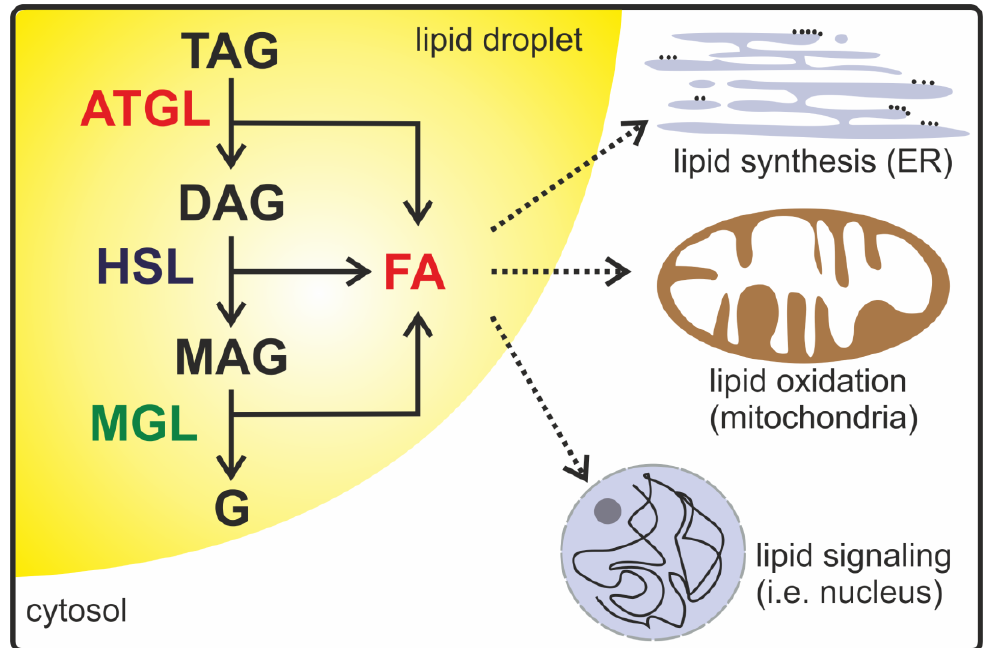
Figure 1. A schematic description of intracellular lipolysis. In the lipolytic active state, adipose triglyceride lipase (ATGL), hormone-sensitive lipase (HSL), and monoacylglycerol (MAG) lipase (MGL) are localized on the surface of lipid droplets in the cytoplasm. ATGL catalyzes the initial step in triacylglycerol (TAG) hydrolysis, generating diacylglycerol (DAG) and fatty acids (FAs). HSL preferentially degrades DAG into MAG and FAs. In the last step, MGL releases FAs and glycerol (G). Lipolytic products such as DAG, MAG, FAs, and glycerol are used as energy resources, signaling lipids, or precursors for lipid synthesis and membrane biosynthesis.